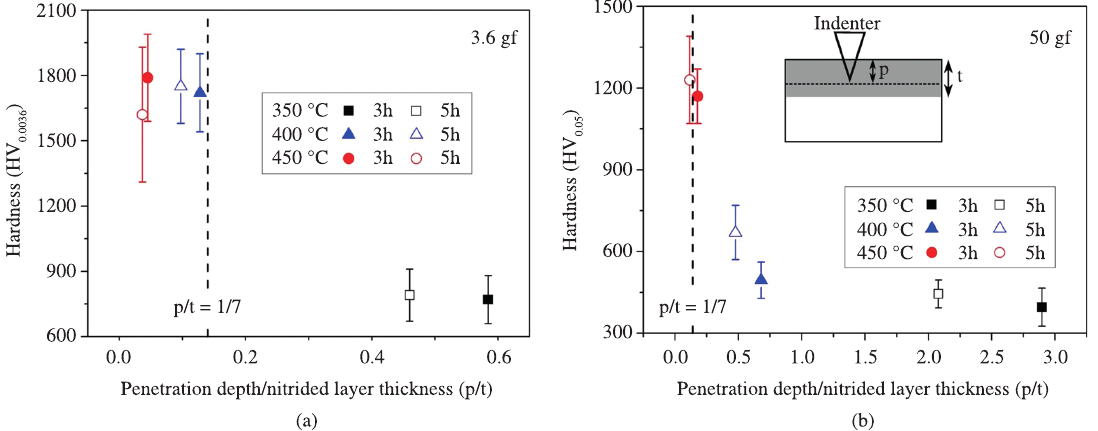
Figure 3. Hardness value as function of ratio between penetration depth p and nitrided layer thickness t, using different loads (a) 3.6 gf (b) and 50 gf.